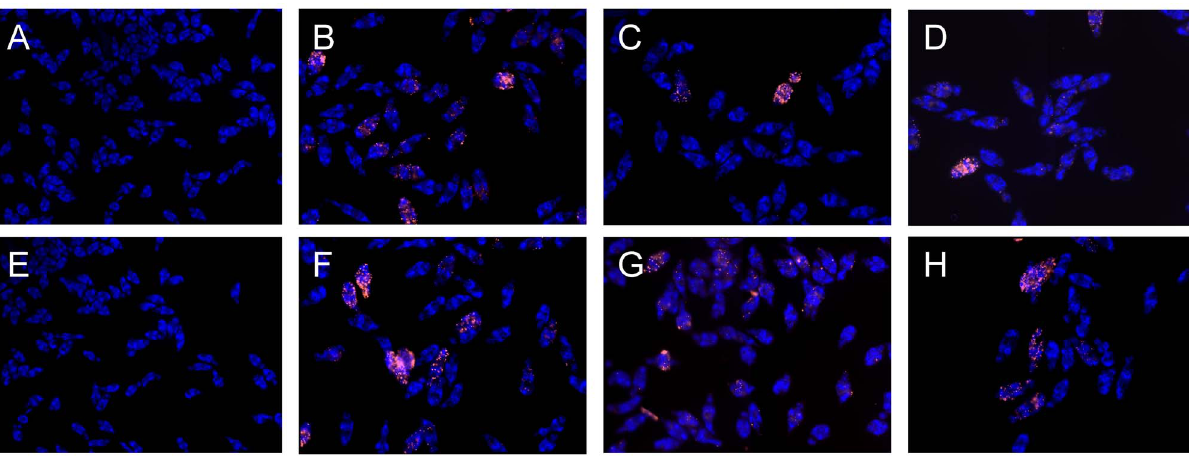
Figure 5. TUNEL labeling of parasite treated for 48 h with DMSO (A, E) or with 10 m M and 20 m M Salermide (B, F), Sirtinol (C,G) and MS3 (D,H) respectively. Positively TUNEL labeled schistosomula are red. The intensity of labeling, as well as the number of positively larvae,